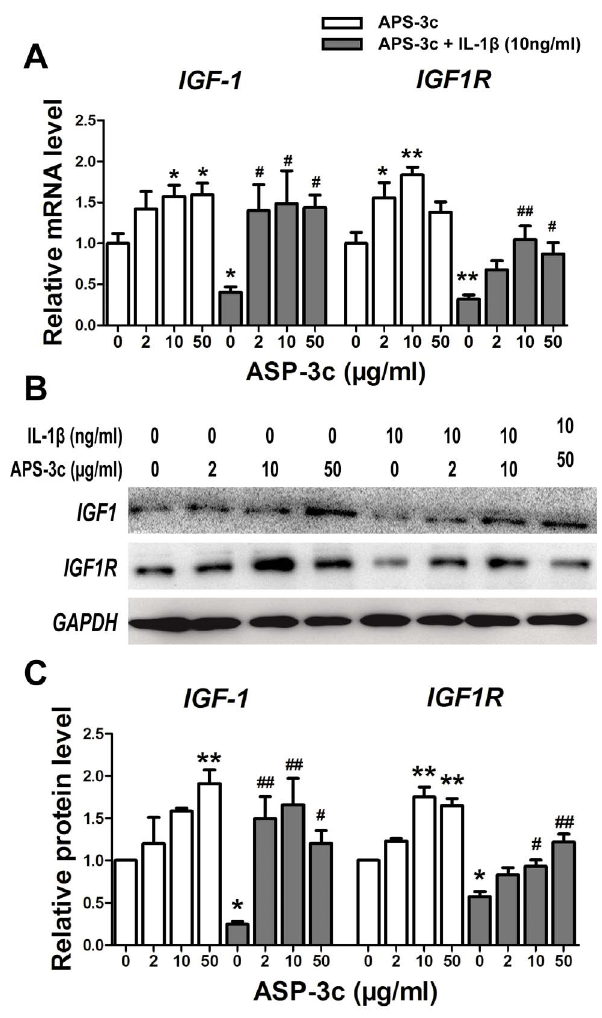
Figure 4. APS-3c stimulated expression of insulin like growth factor (IGF1) and its receptor (IGF1R) invitro . The mRNA and protein level of IGF1 and IGF1R were detected in human primary chondrocytes treated with ASP-3c (2,10 and 50 m g/ml) or/and interleukin 1 beta (IL-1 b ) for 48 h. Values were presented as mean 6 SEM from three independent experiments. * P , 0.05, ** P , 0.01 versus control group; # P , 0.05, ## P , 0.01 versus IL-1 b group.